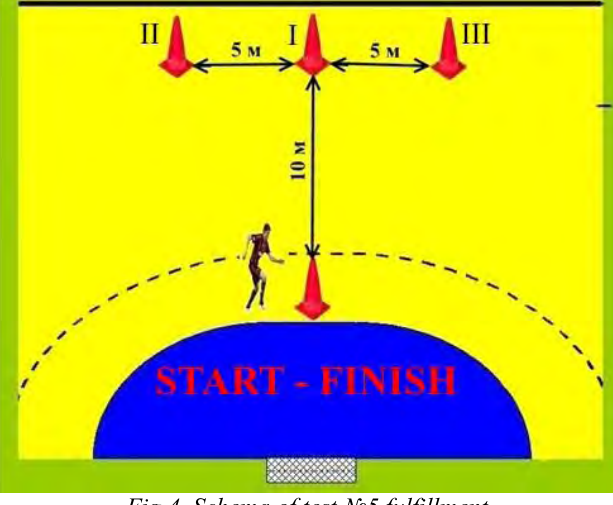
Fig.4. Schema of test №5 fulfillment